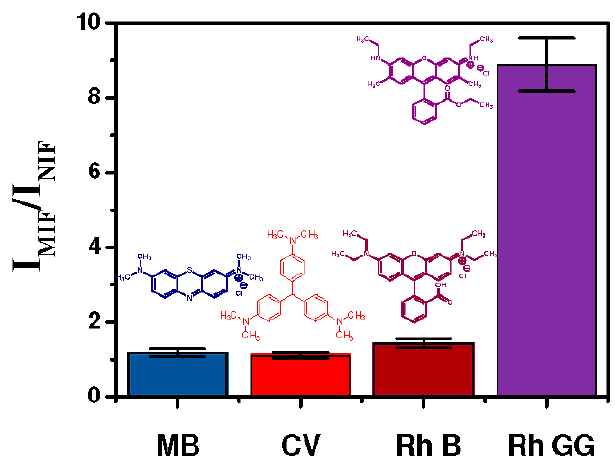
Figure 11. Selectivity of MIF@GO-AgNPs substrate towards solutions of methylene blue (MB, 1393 cm − 1 Raman mode), crystal violet (CV, 1375 cm − 1 Raman mode), rhodamine B and 6G (RhB and Rh6G, 1510 cm − 1 Raman mode) with respect to the NIF@GO-AgNPs substrate.